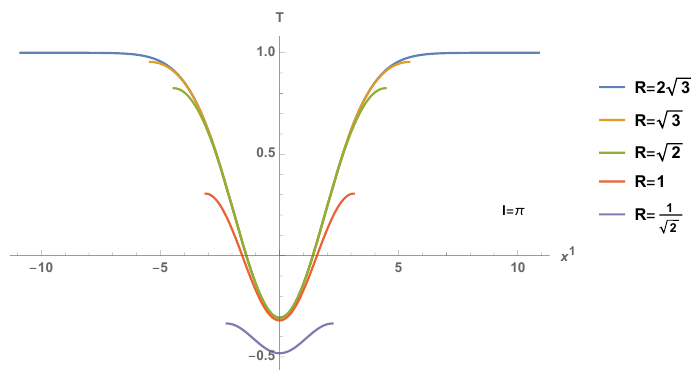
Figure 19 . Tachyon lump pro(cid:12)les in the toy model derived from unexcited Neumann-Dirichlet twist (cid:12)elds of weight 1 = 16, for various